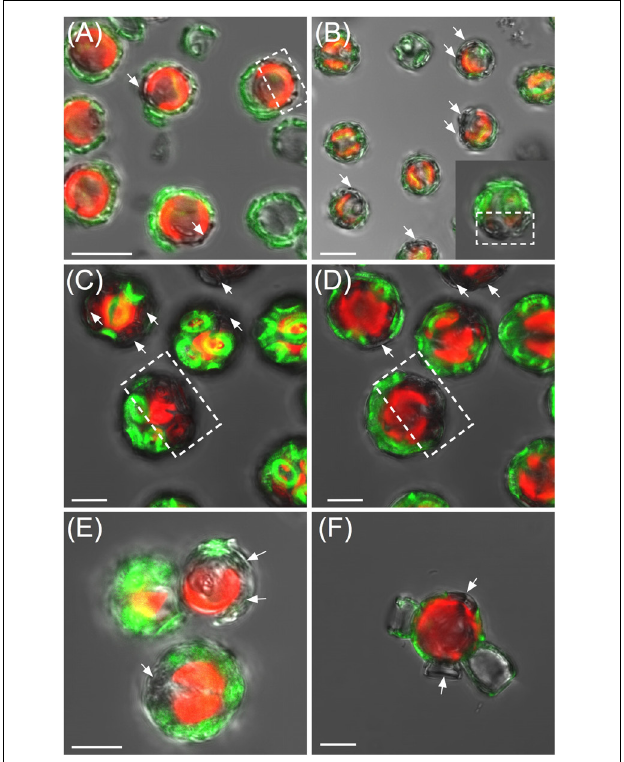
FIGURE 6 | Tracking of heterococcolith production using calcein. (A) Emiliania huxleyi 10 h post-staining showing cells that have secreted several new coccoliths, examples highlighted with arrows. In some cells, a clear polarity was observed in the position of the newly synthesized coccoliths (unstained, highlighted by dotted box). (B) Gephyrocapsa oceanica 10 h post-staining. (C) Coccolithus braarudii 24 h post-staining. (D) Mid-section of the same Coccolithus braarudii cells in (C) . (E) Calcidiscus leptoporus 18 h post-staining. (F) Scyphosphaera apsteinii 24 h post-staining. Fluorescence was retained for individual coccoliths for at least 72 h, although overall fluorescence per cell diminished as new coccoliths were produced and cells divided. Scale bars represent 5 µ m.